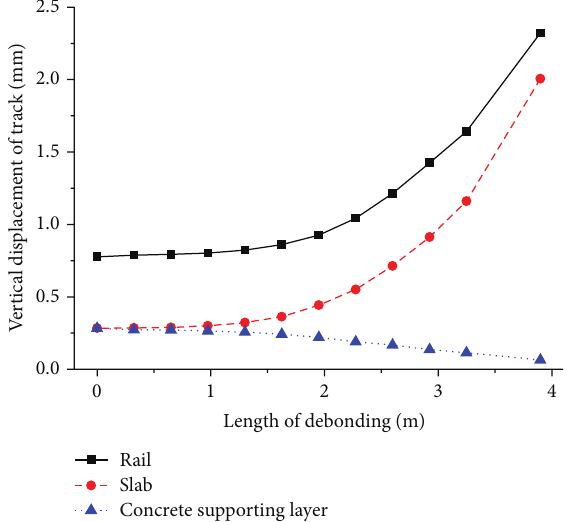
Figure 9: Time history of vertical dynamic compressive stress of CA mortar. Figure 10: The vertical displacement of track structure.